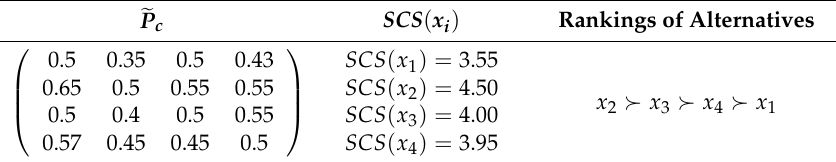
Table 4. The detailed results of the special case of the SC-FPRs ( i =